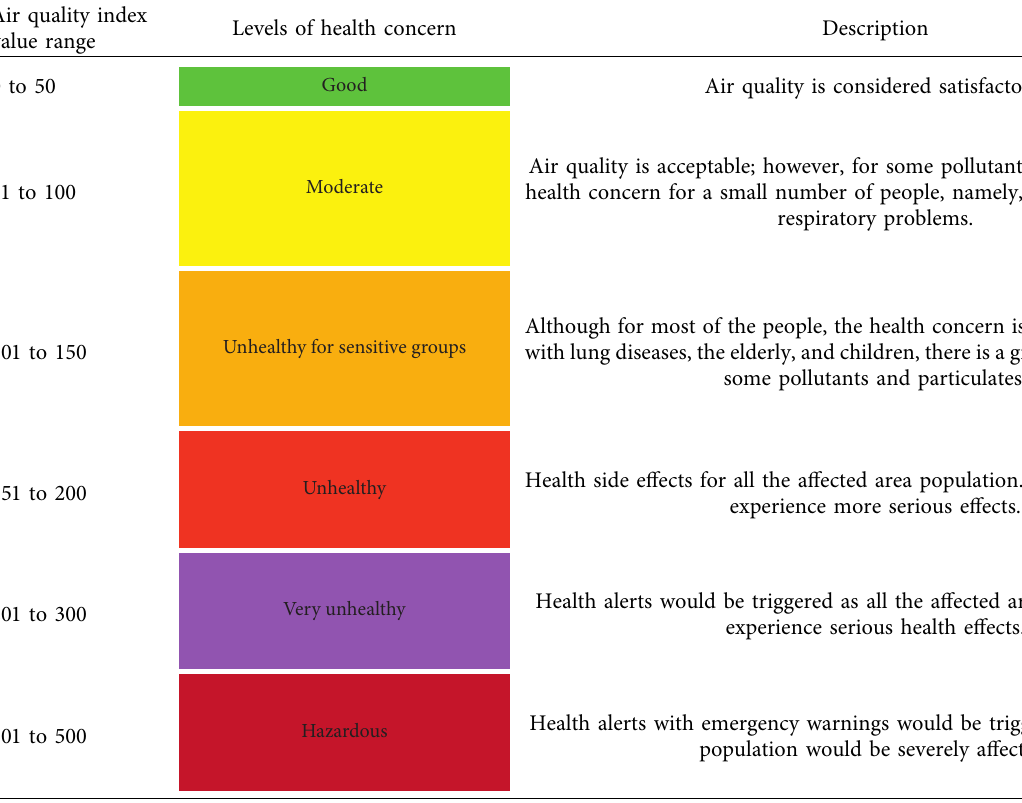
Table 11: The six AQI categories defined by EPA.